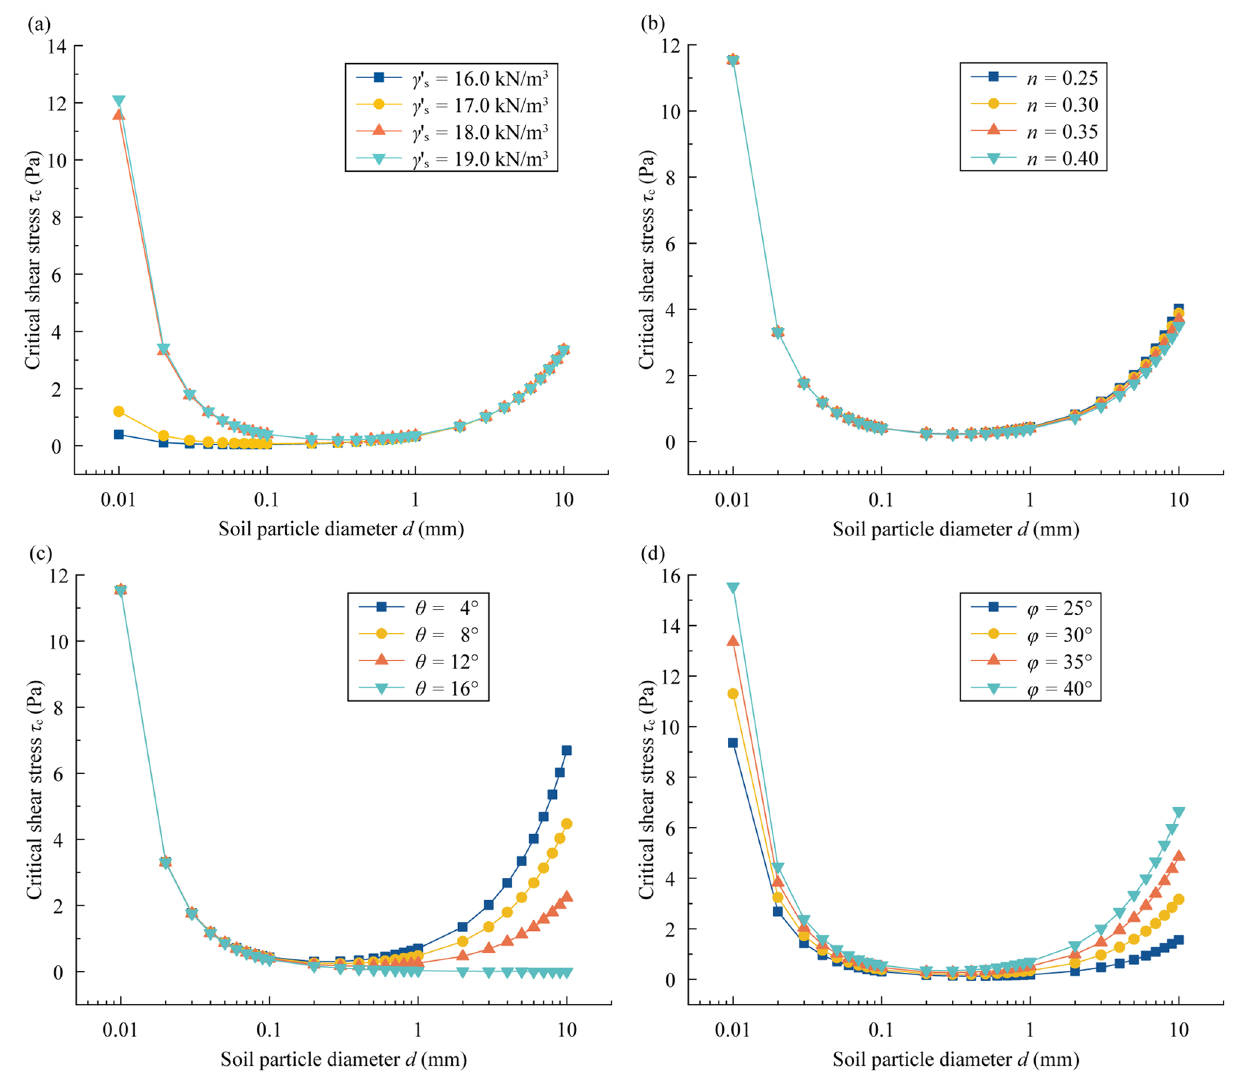
Figure 10. Sensitivity analysis for the effect of different parameters on the estimation of the critical shear stress: ( a ) soil unit weight, ( b ) porosity, ( c ) slope gradient, and ( d ) internal friction